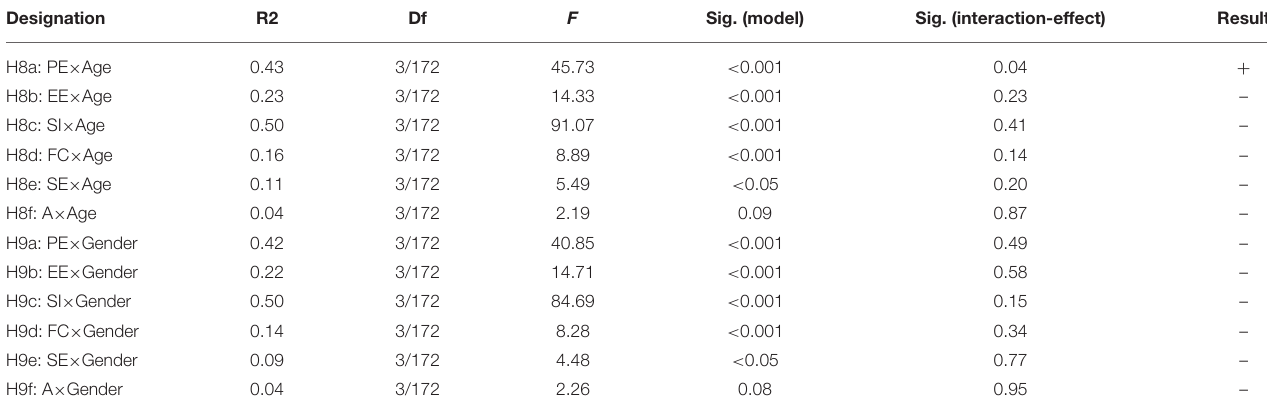
TABLE 10 | Influence of moderators on behavioral